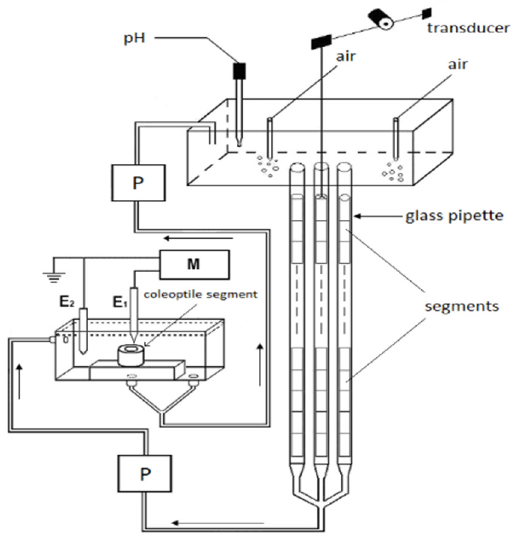
Figure 9. A schematic drawing of the apparatus that was used to simultaneously measure the elongation growth, medium pH and membrane potential of the coleoptile cells. The longitudinal extension of a stack of the segments was recorded in an intensively aerated solution using an angular transducer. The elongation growth, medium pH and membrane potential were measured with multifunctional computer meters: P, peristaltic pump; M, multifunctional computer meter; E 1 and E 2 , reference and internal electrode, respectively.